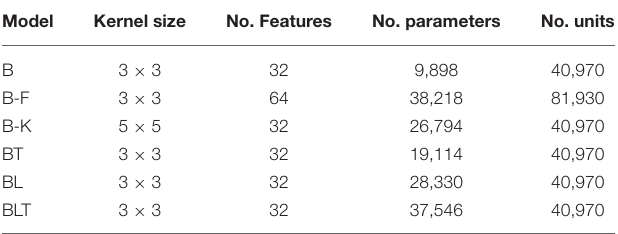
TABLE 1 | Brief descriptions of the models used in these experiments including the number of learnable parameters and the number of units in each model.